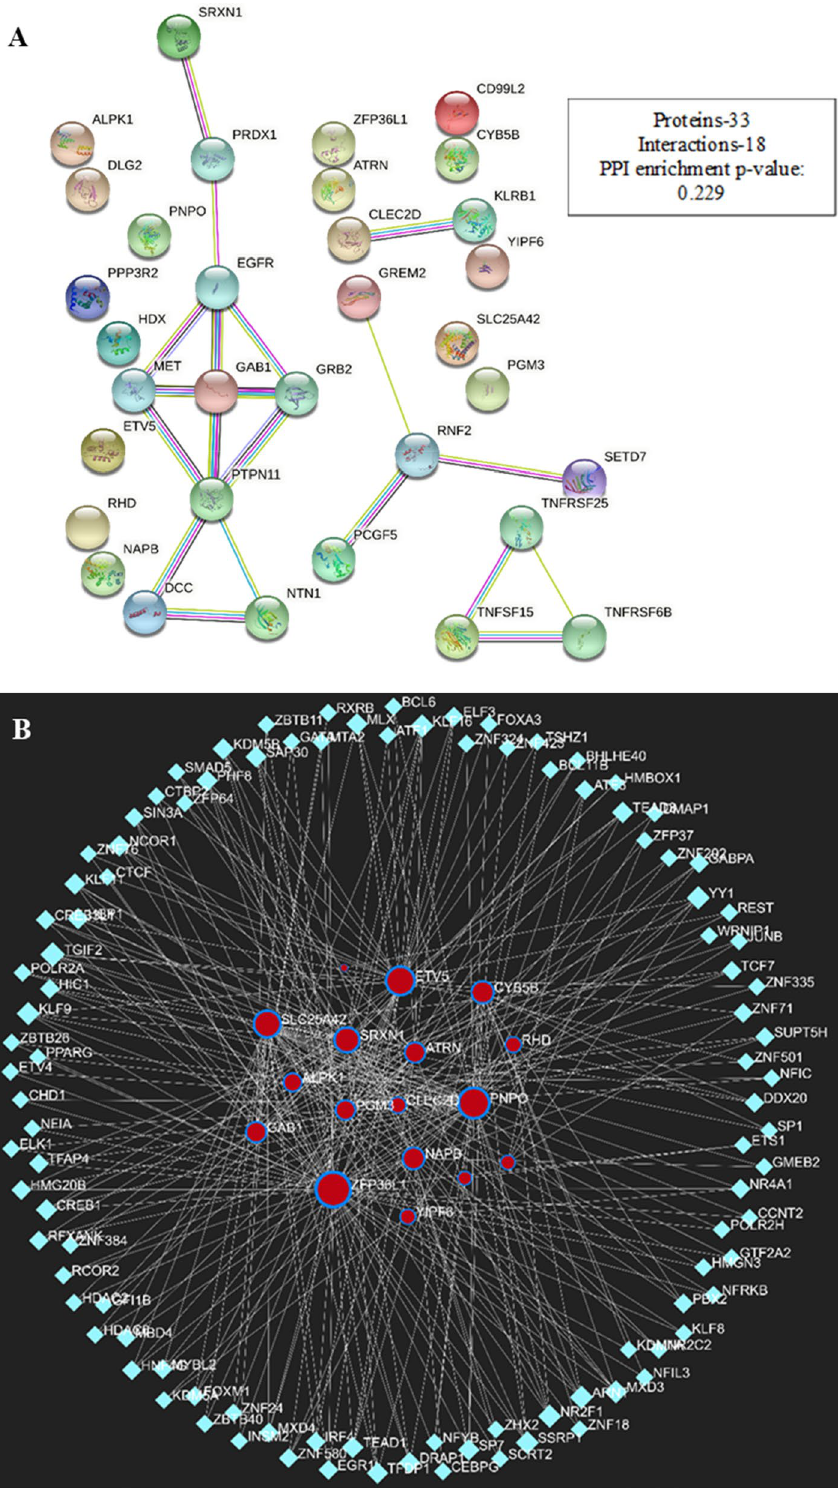
Fig. 3 A The enrichment analysis of protein- protein annotation of target genes through STRING and B Gene–gene interaction of targeted genes network analyst algorithm. Red node shows the predicted human target gene and blue node shows the interaction with target